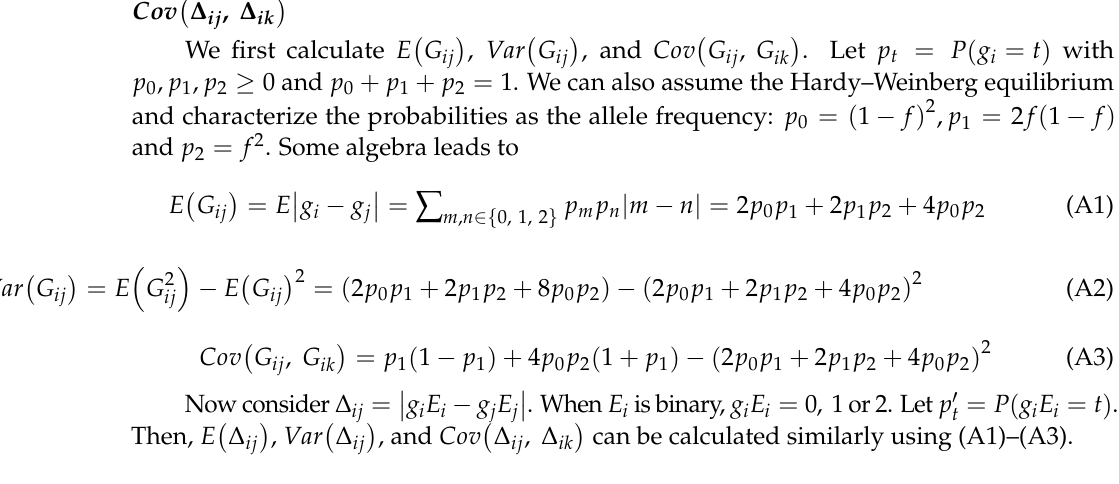
on 10 8 simulations. Table S2: Association P-values between lung cancer risk SNPs and micro- biome composition in the EAGLE data. Figure S1: Quantile-quantile (QQ) plot for association p -values testing the joint effects (main effect and SNP by smoking interaction) using the unweighted UniFrac distance matrices. Figure S2: Derivation of the likelihood ratio statistic Q in (7) and (8). Figure S3: Calculations related with genetic